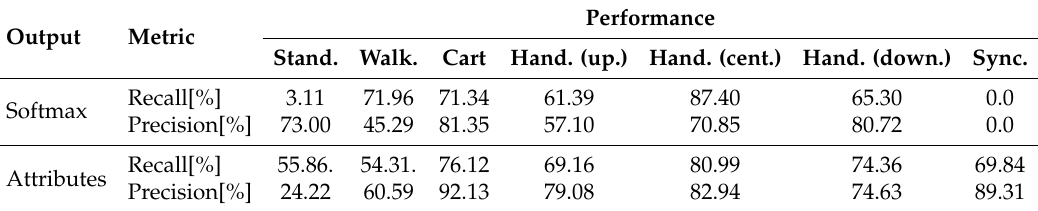
Table 9. Recall [ % ] and precision [ % ] of human activity recognition (HAR) on the LARa OMoCap dataset.